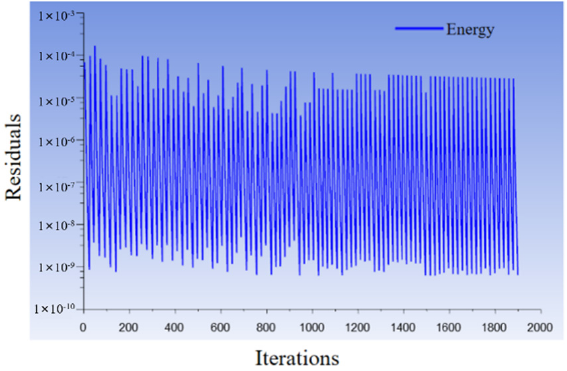
Figure 7. Residual errors of the energy equation.